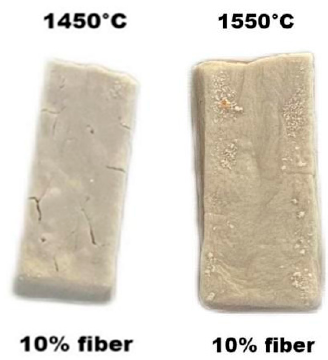
Figure 11. After 1150 ◦ C treatment for 1h, the surface cracks of the sample.